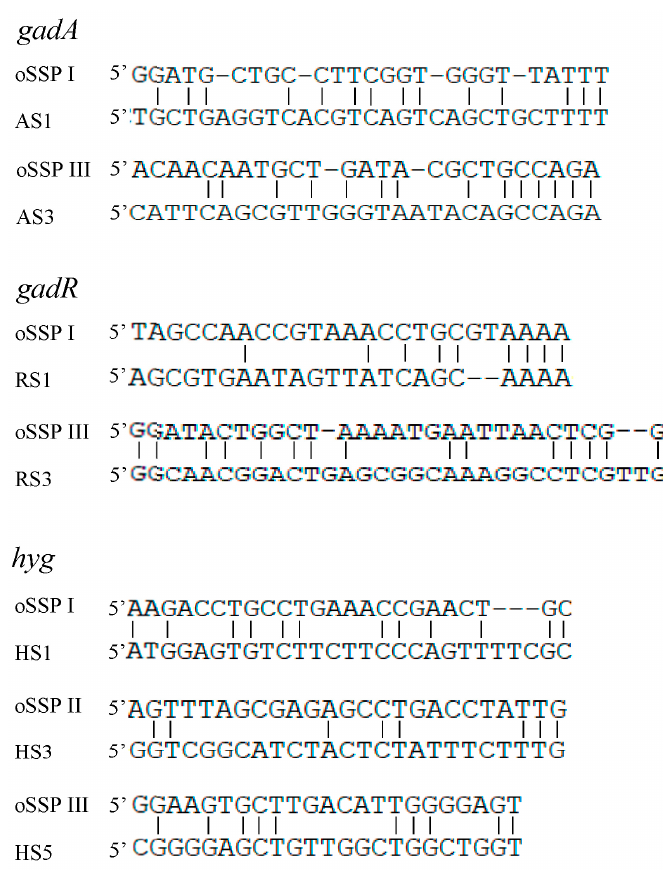
Figure 3. Partial annealing locations of the oSSP primers. The DNA bands AS1-AS3, RS1-RS3, and HS1-HS5 correspond to the ones described in Figure 2.